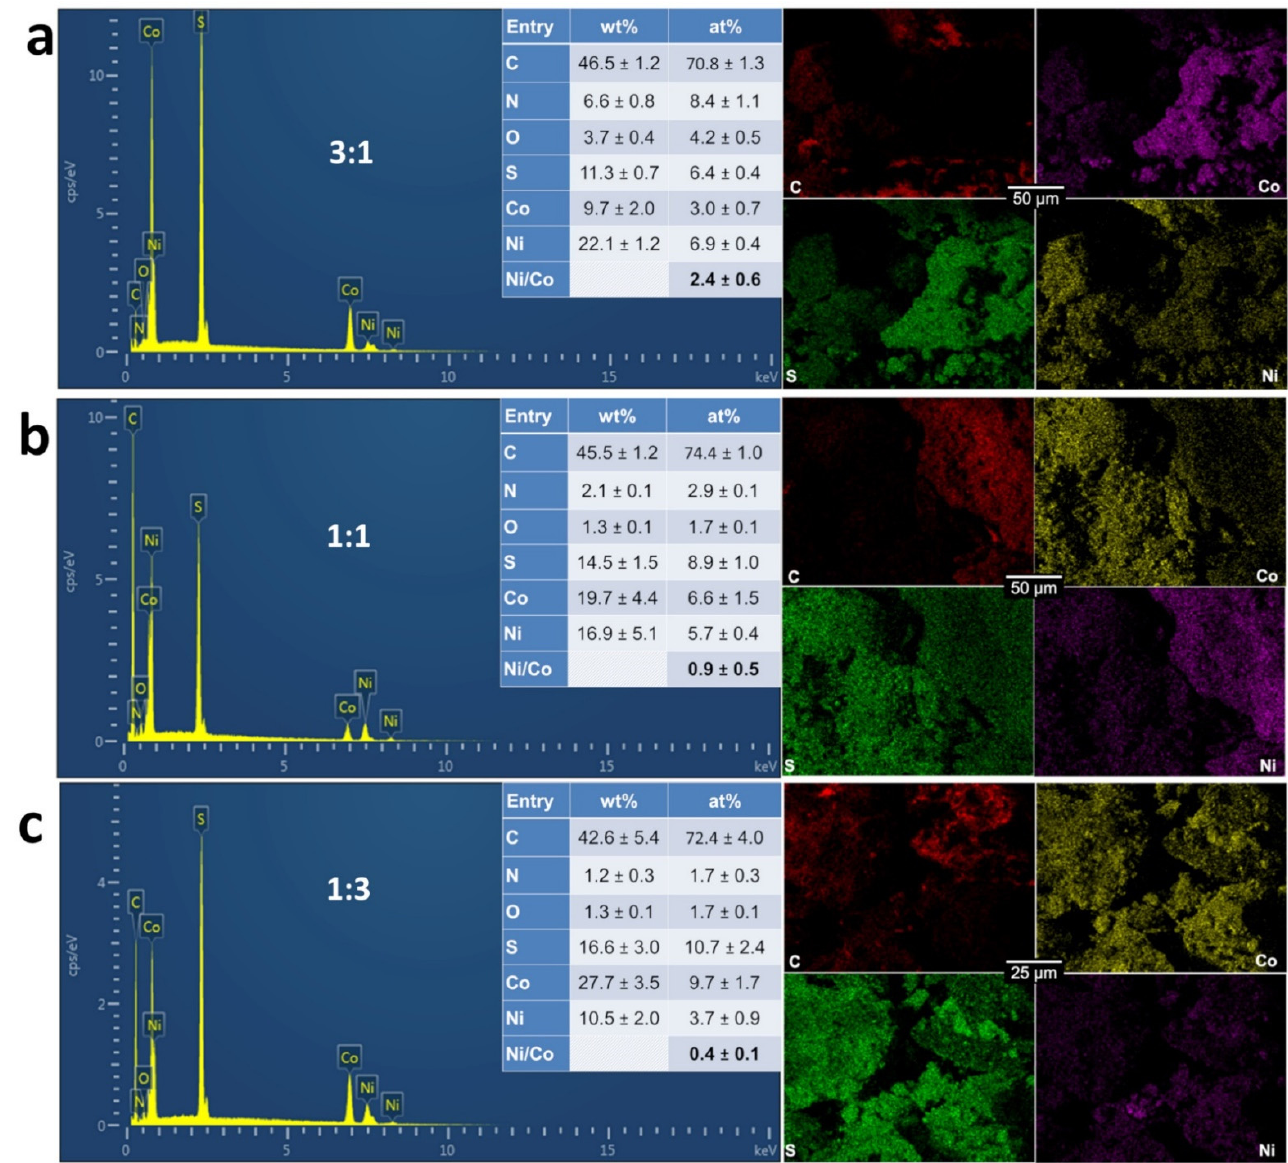
Figure 5. EDX spectra and the corresponding EDX maps of the as-synthesized bimetallic electrocatalysts for PANI-Ni:PANI-Co ratios of: 3:1 ( a ), 1:1 ( b ), and 1:3 ( c ) based on atomic ratio of Ni:Co after calcination.